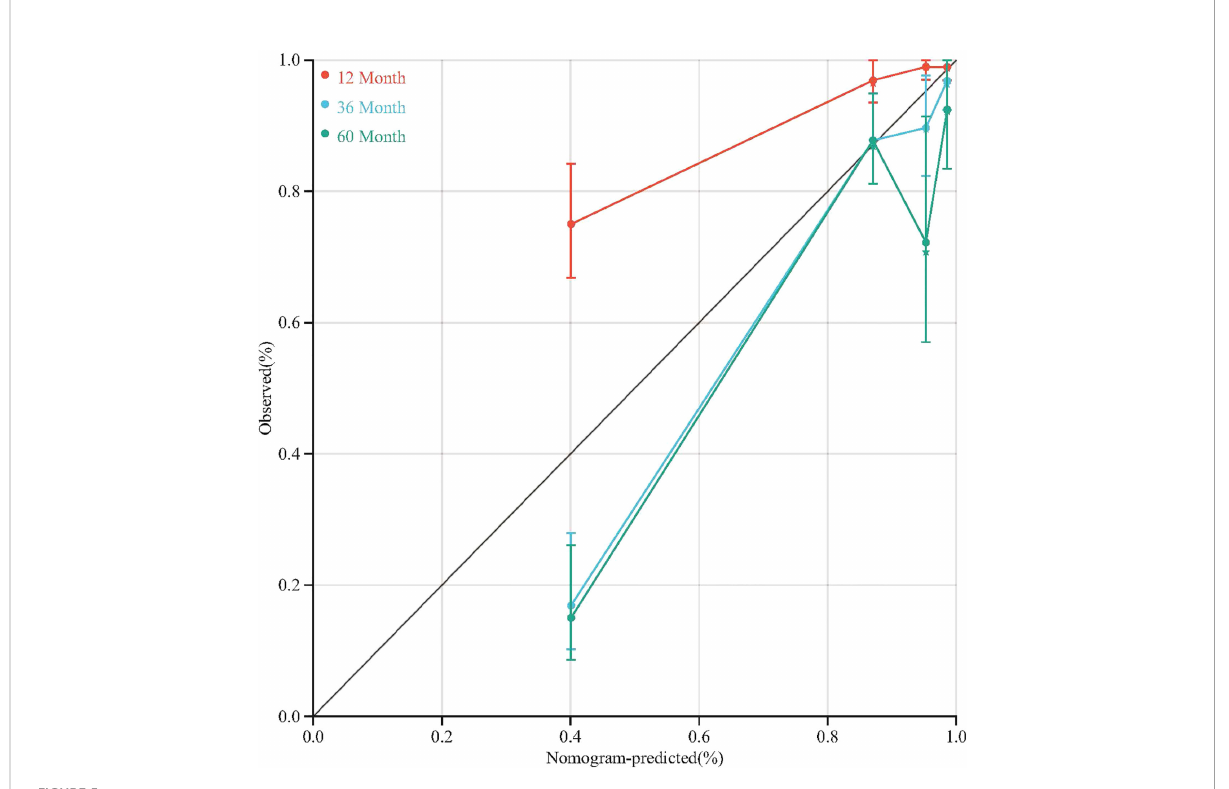
FIGURE 5 Calibration plots of the nomogram for 12-/36-/60-month incidence of